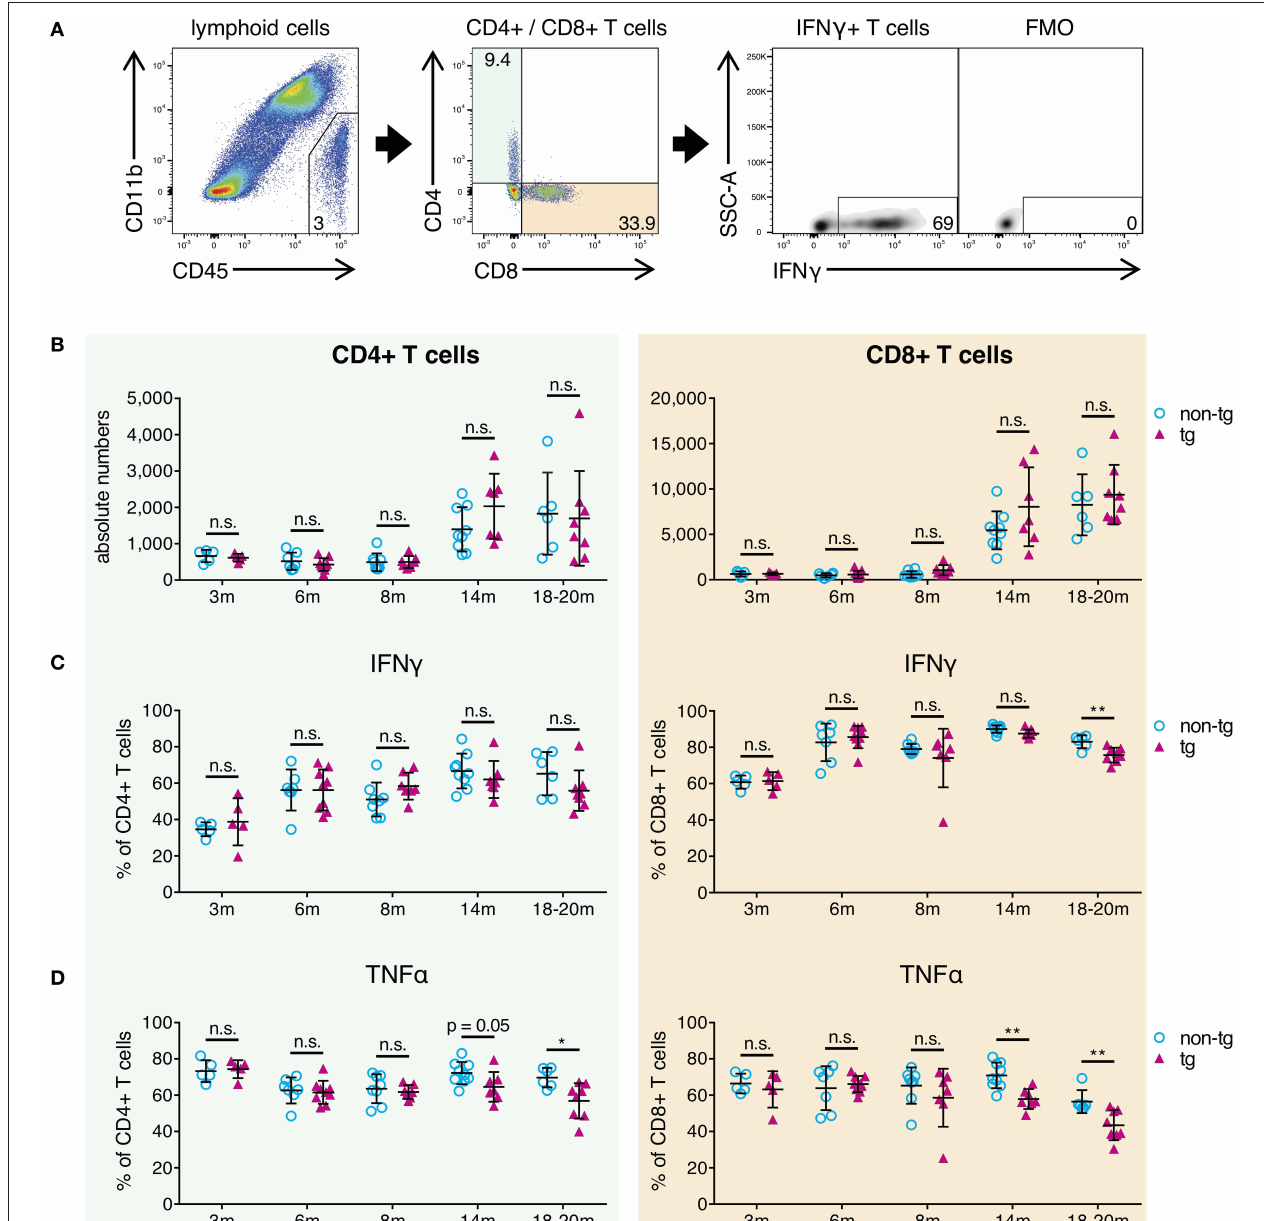
FIGURE 3 | Decrease of pro-inflammatory CD4 + and CD8 + effector T-cells in brains of aged APP-PS1 transgenic mice. (A) Schematic of flow cytometry analysis of cerebral lymphoid cells derived from APP-PS1 mouse brains. T-cells (TCR β + ) are identified in lymphoid cell population (CD45 + , CD11b-) and subdivided into CD4 + T-helper cells and CD8 + cytotoxic T-cells. FMO = fluorescence minus one control. Numbers in gates and quadrants indicate percent cells of parental gate. (B) Baseline numbers of CD4 + and CD8 + T-cells increase during aging. However, no difference is observed between non-tg and APP-PS1 tg animals. (C,D) Flow cytometry analysis of intracellular pro-inflammatory IFN γ - and TNF α -content reveals (C) decreased frequency of IFN γ -producing CD8 + T-cells at 18–20 months of age and (D) reduced frequency of TNF α -secreting CD4 + and CD8 + T-cells starting at 14 months of age in APP-PS1 tg animals. Each symbol represents data from one mouse. 3m, n = 5 (non-tg), n = 5 (tg); 6m, n = 7 (non-tg), n = 9 (tg); 8m, n = 8 (non-tg), n = 7 (tg); 14m, n = 9 (non-tg), n = 7 (tg); 18-20m, n = 6 (non-tg), n = 8 (tg). (Data are shown as mean ± SD, * p < 0.05, ** p < 0.01, n.s. = non-significant, two-way ANOVA with Bonferroni’s multiple comparisons test).